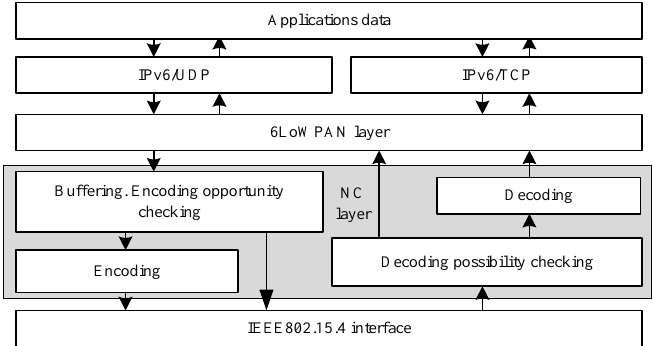
Figure 2. Location of the Network Coding (NC) layer.